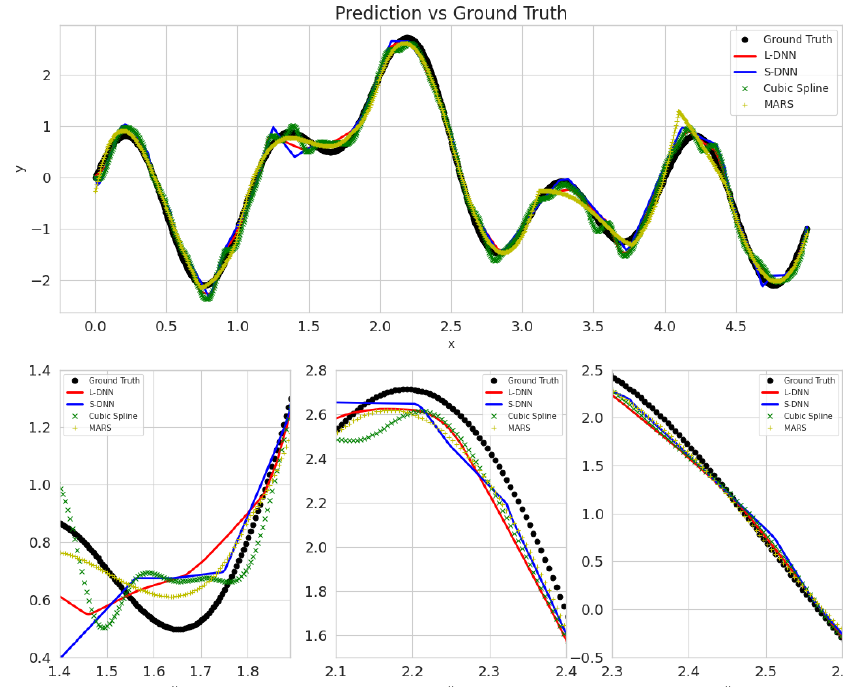
Figure A3. Predictions’ of all tested methods on the test set for noise = 10%, trained on 50 samples. Blue represents SDNN, red LDNN, green cubic splines, and yellow MARS.